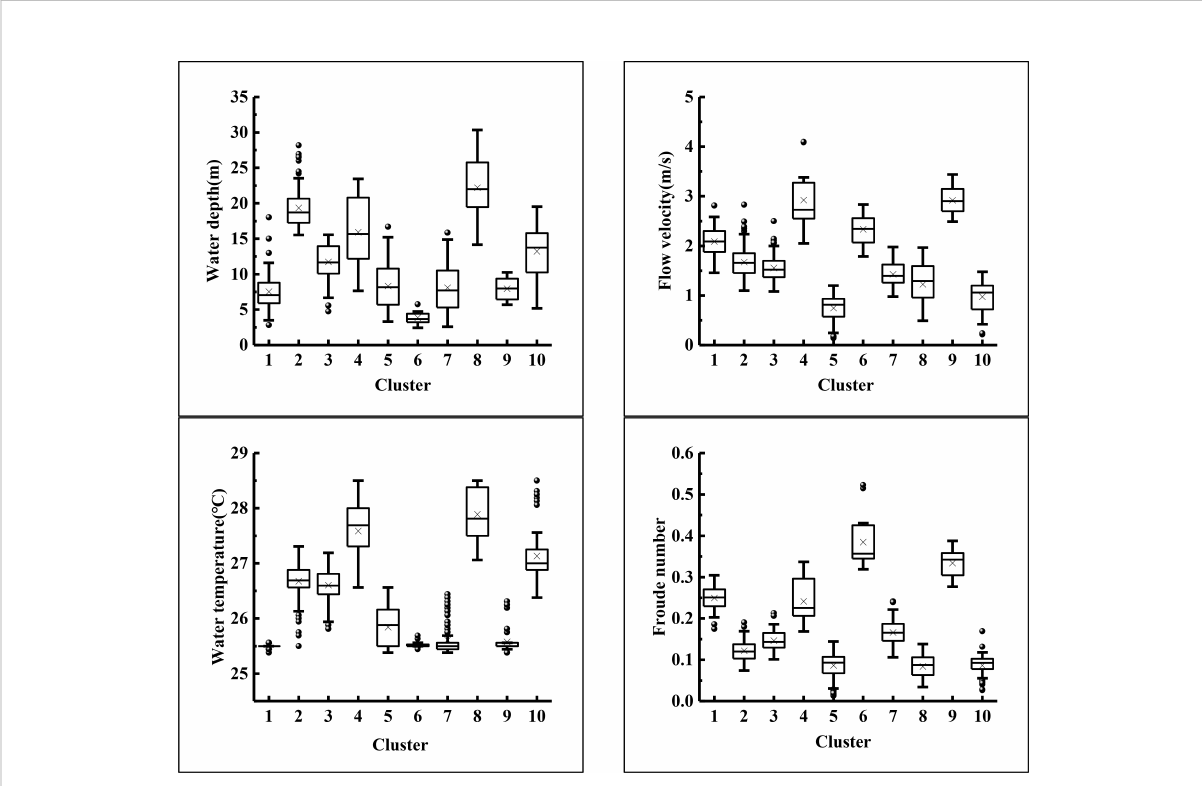
FIGURE 8 Characteristics of the 10 hydrologic and hydrodynamic types as determined by cluster analysis (see the Materials and Methods section for more detail). Each cluster de fi ned by four hydrologic and hydrodynamic factors: water depth, fl ow velocity, water temperature, and Froude number. Cross shapes show the average value of each factor in a cluster, which indicates the average position of a cluster. Box plots show the parameter dispersion values in the clusters. For box plots, lines represent the lower, median, and upper quartiles. Whiskers are the lines extending from the two opposite ends of the box plots, showing the range of the remaining data. Outliers are the data whose index value exceeds the whiskers (where whisker length is limited to 1.5 of the